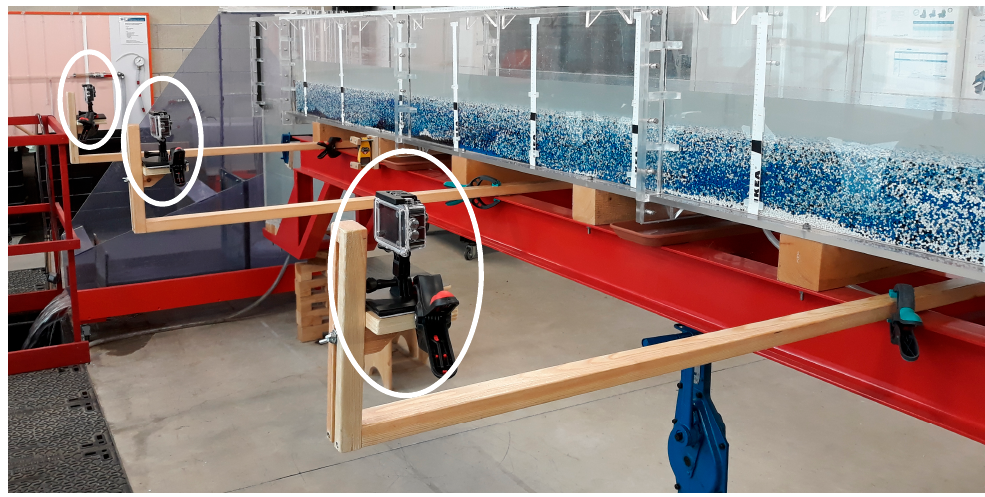
Figure 10. The cameras for the measurement of the bed elevation (flume view from upstream).